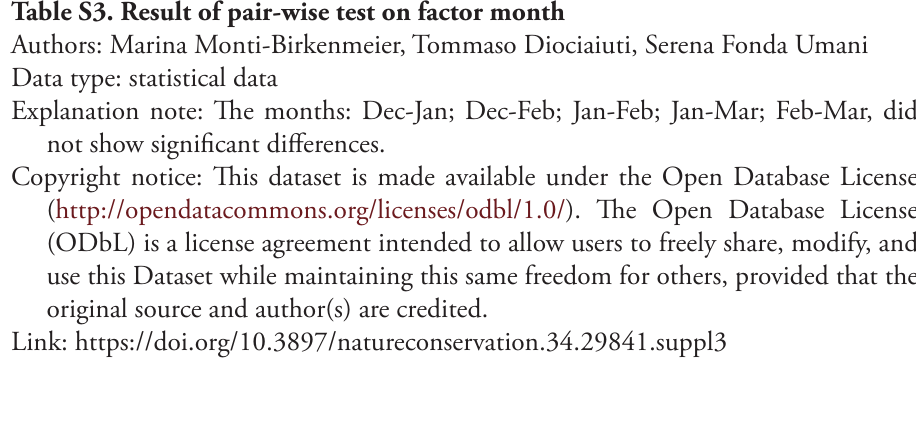
Table S3. Result of pair-wise test on factor month